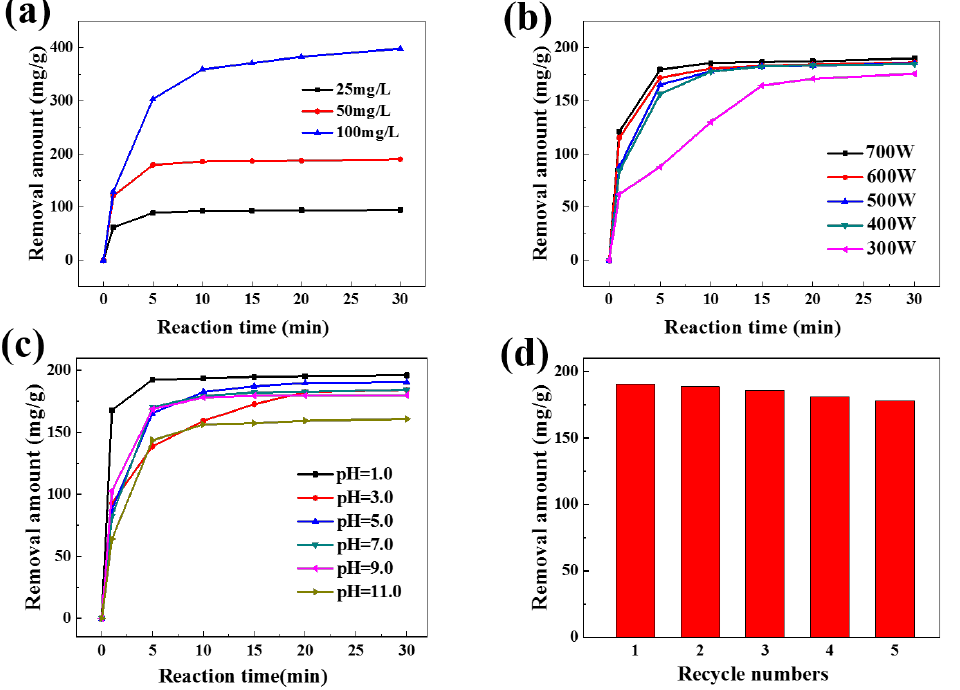
Figure 6. Effect of the initial concentration of TC ( a ), microwave power ( b ), and solution pH ( c ) on the degradation of TC, and cycle stability test for MnO / CNTs ( d ).